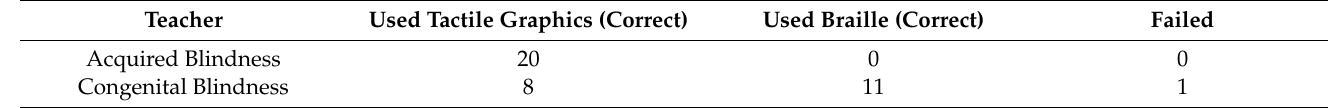
Table 6. Testing with the tactile